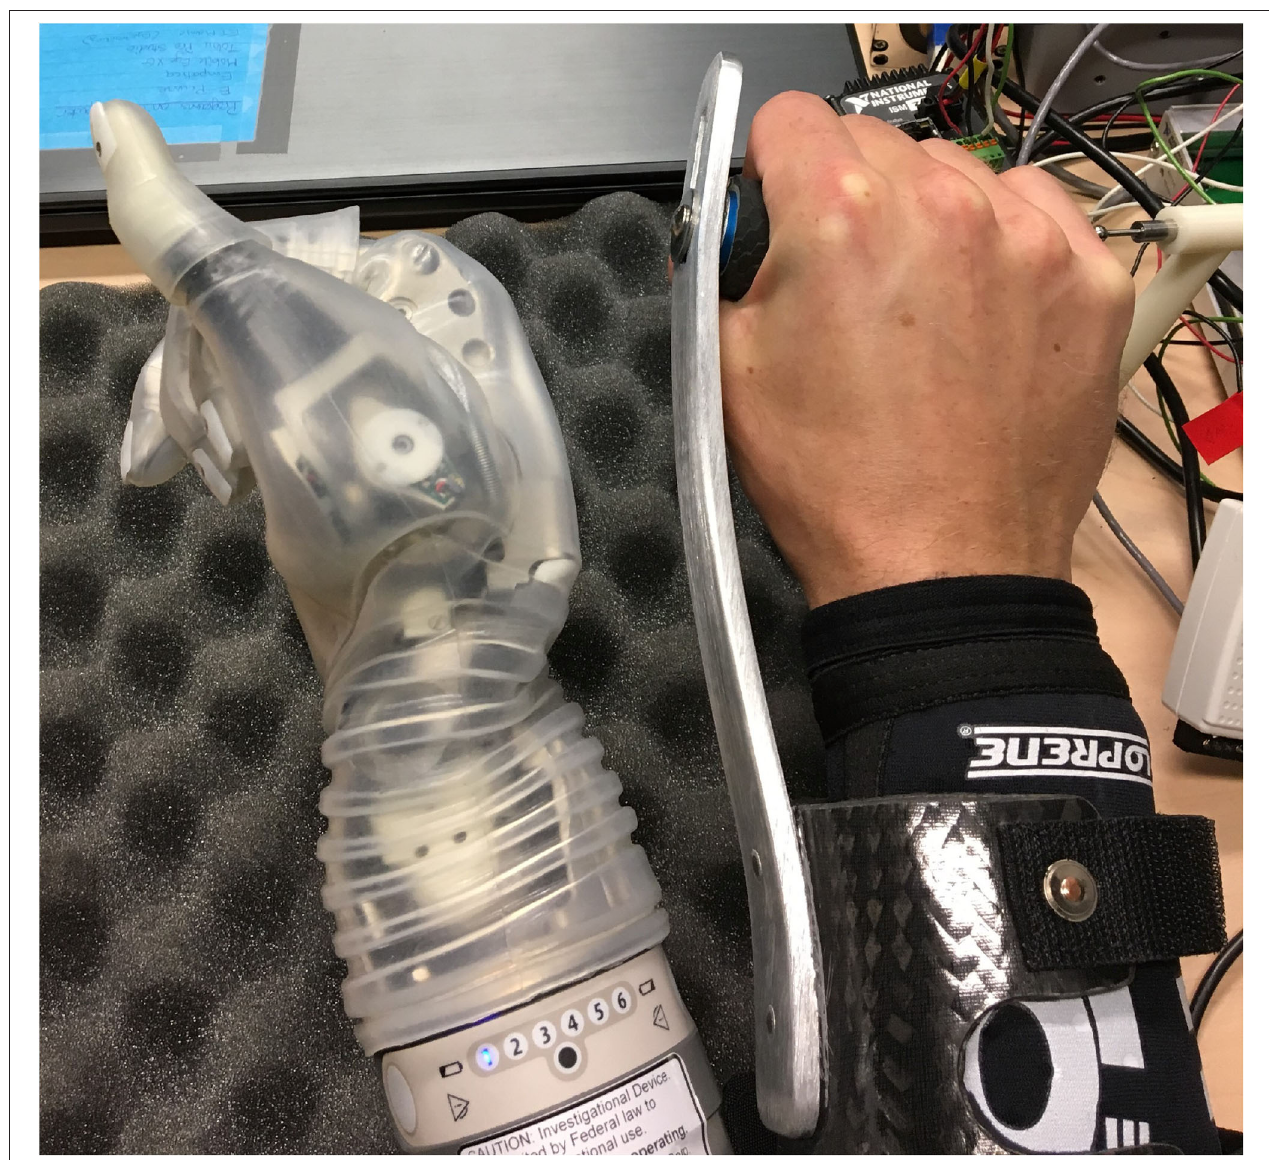
FIGURE 4 | The DEKA Arm was attached to a bypass to allow able-bodied individuals to wear the prosthesis.